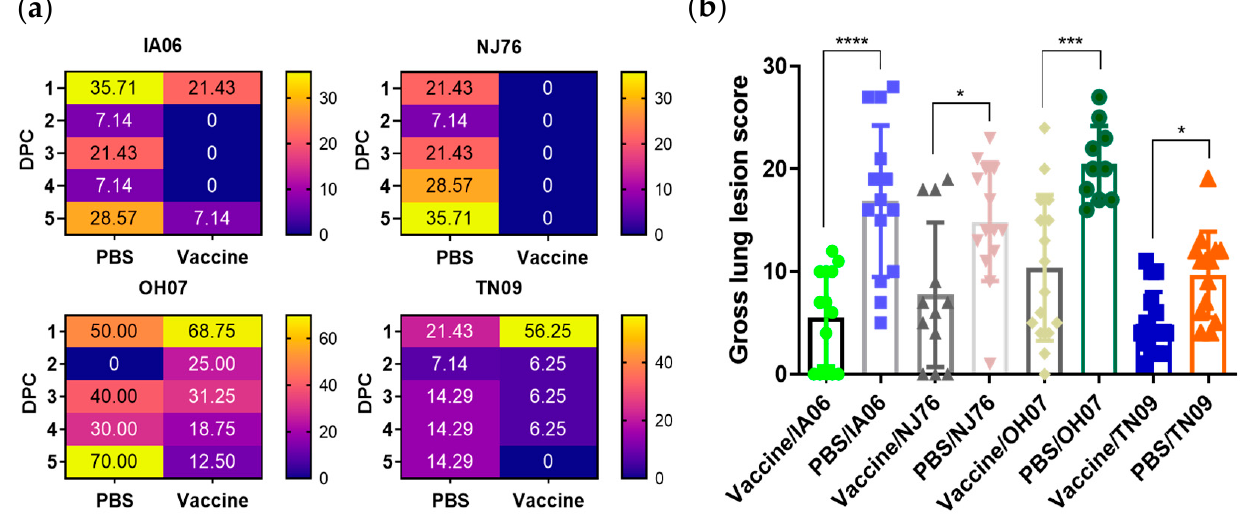
Figure 5. Clinical observations in neonatal piglets. ( a ) Percent of piglets displaying fever (>104 °F) after challenge with four reassortant parental viruses. Sows were inoculated with either vaccine or PBS, and neonatal piglets were challenged with each of the four reassortant parental viruses (TX98-IA06, TX-98-NJ76, TX98-OH07, and TX98-TN09). Rectal temperature was measured daily after challenge. ( b ) Gross lung lesions of piglets born from each individual sow. The X-axis shows each treatment group displayed by specific symbol with different colors. Statistical significance was determined by one-way ANOVA (Tukey’s test) and is indicated with asterisks (*, p < 0.05; ***, p < 0.001; ****, p <